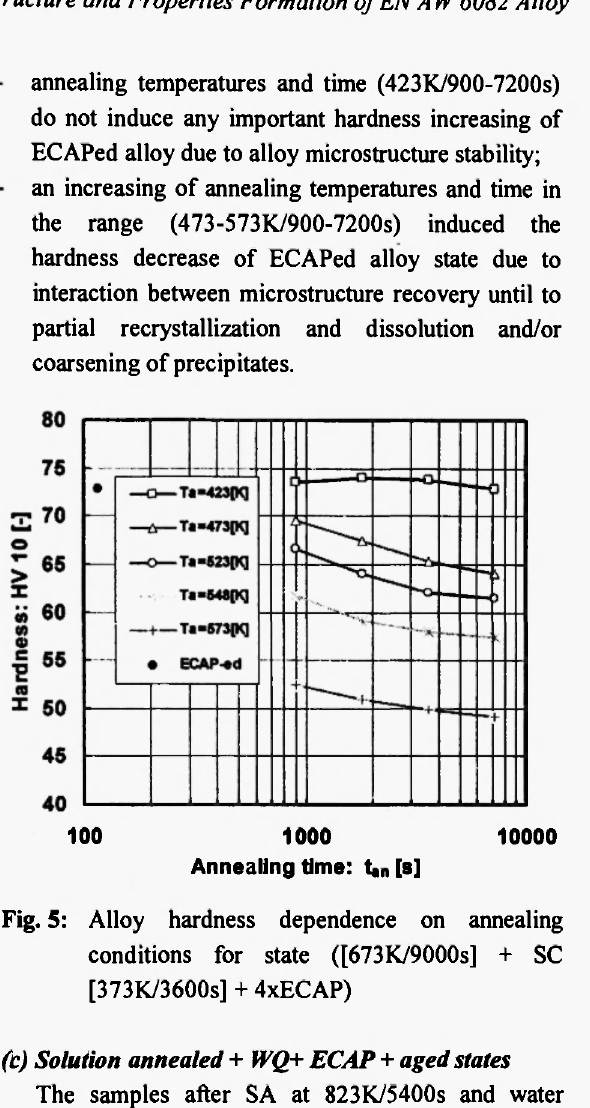
Fig. 5: Alloy hardness dependence on annealing conditions for state ([673K/9000s] + SC [373K/3600s] + 4xECAP) (c) Solution annealed + WQ+ ECAP + aged states The samples after SA at 823K/5400s and water quenched were ECAPed (3 passes) at